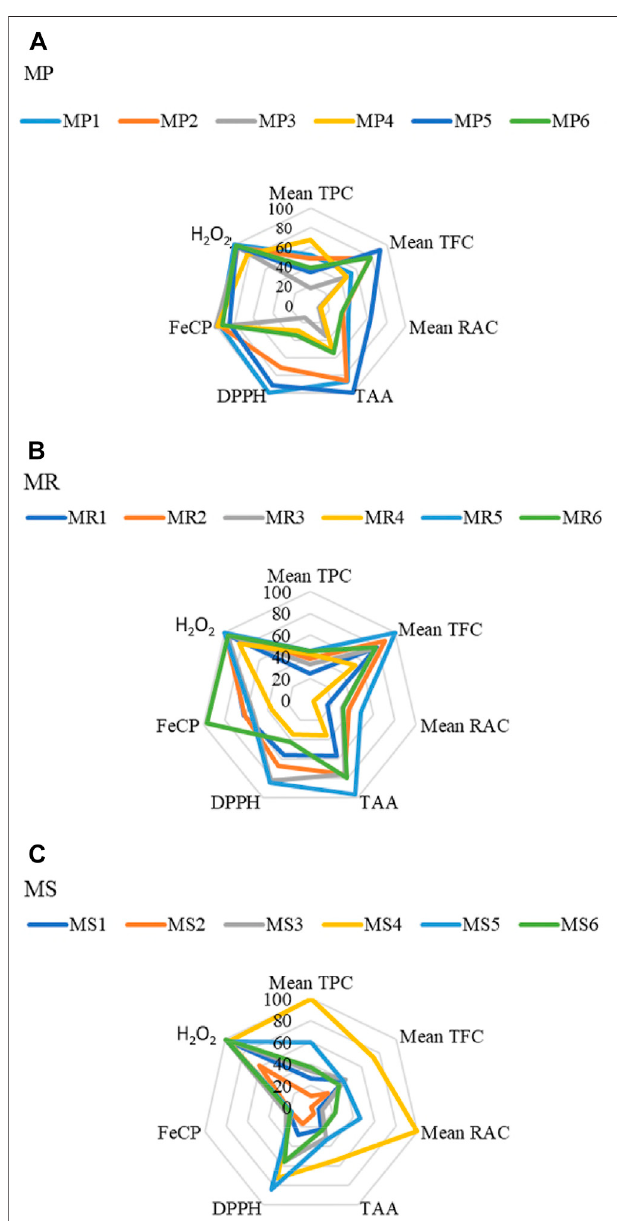
FIGURE 2 | Radar graphs showing the variation of phenolic contents and antioxidant capacities of Mentha samples collected from